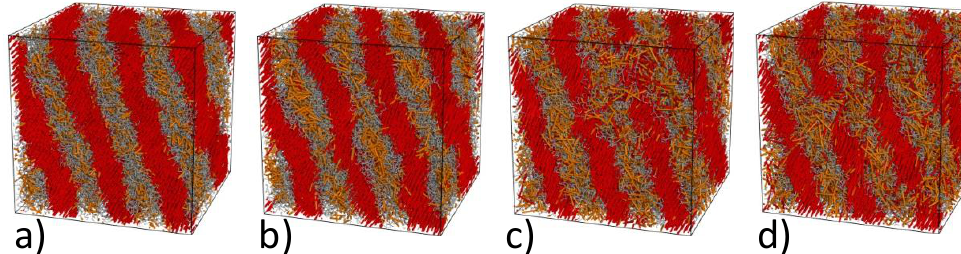
Figure 4. Snapshots of the triblock A 10 B 10 A x rod-coil-rod (red-gray-orange) copolymers at weak immiscibility between A and B particles ( a AB = 30, a AA = a BB = 25) for x = 3 ( a ), x = 4 ( b ), x = 5 ( c ), and x = 6 ( d ).